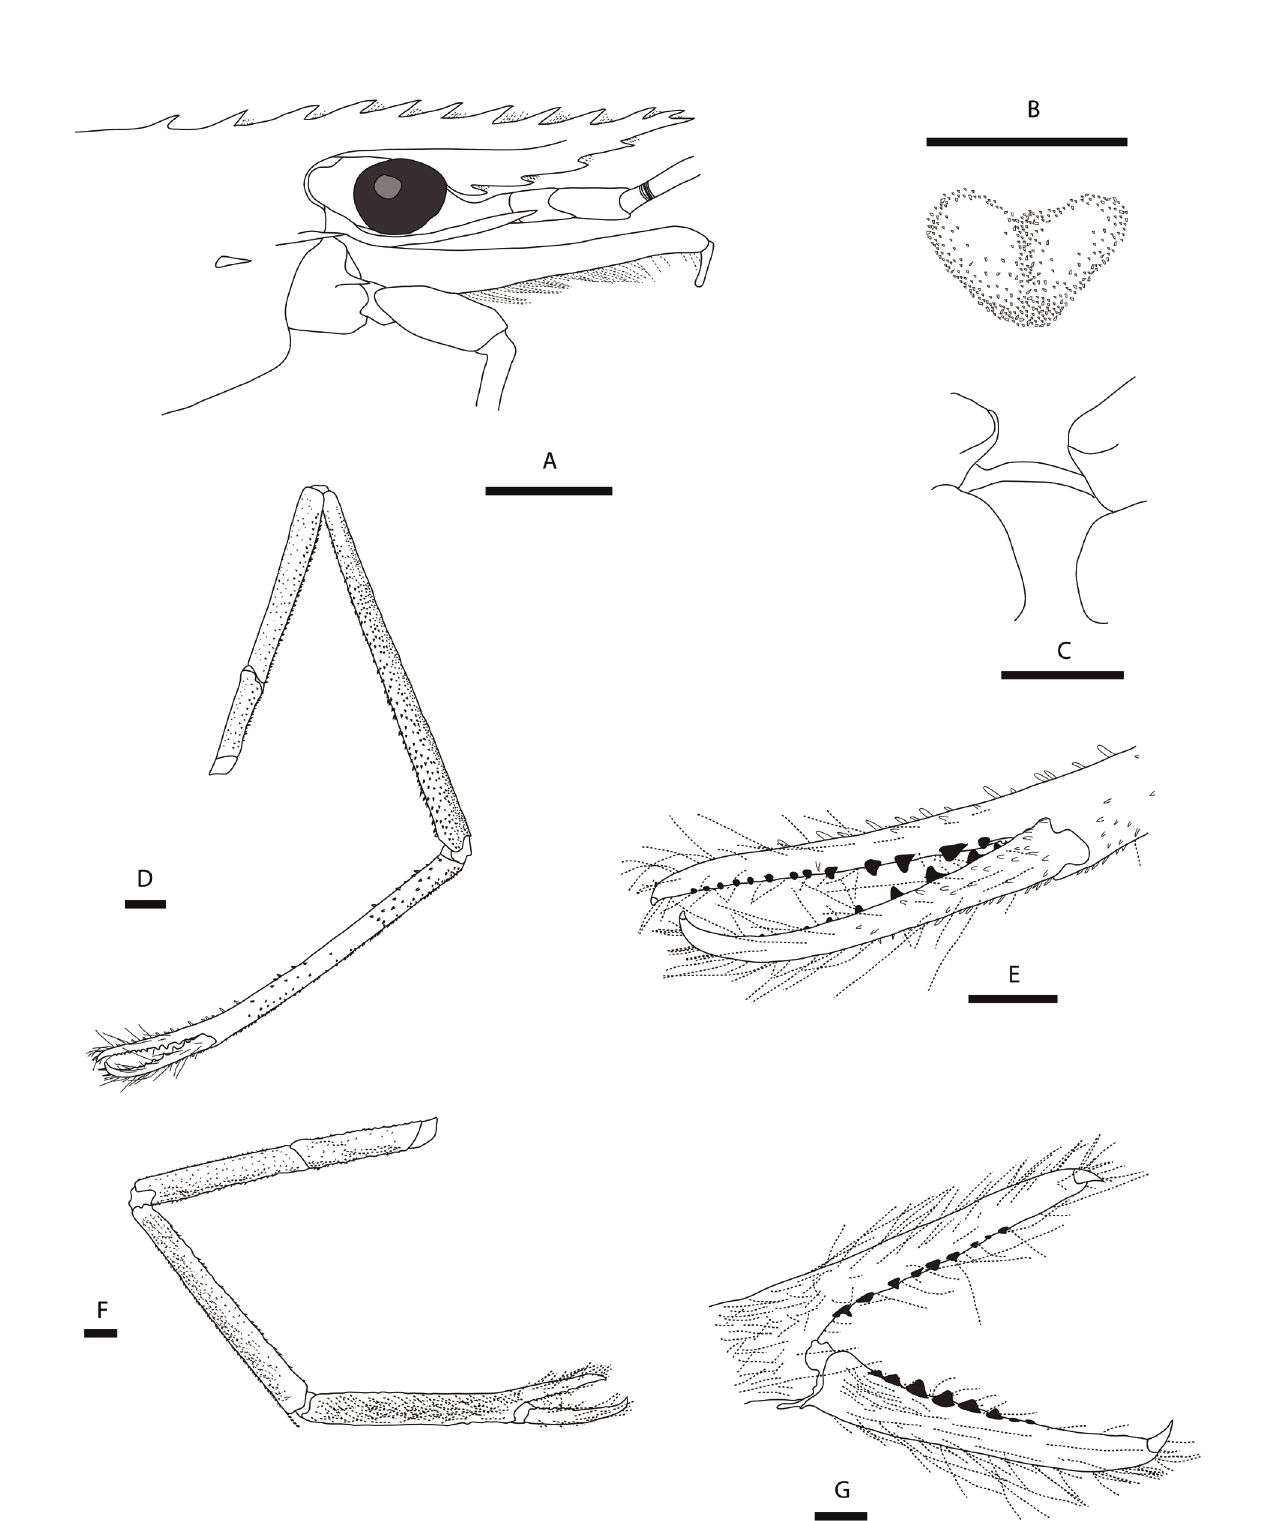
Fig. 3. Macrobrachium australe (Guérin-Méneville, 1838 in Guérin-Méneville 1829–1838), MNHN- IU-2013-13198. A . Cephalothorax. B . Epistome. C . Fourth thoracic sternite. D . Major second pereiopod. E . Major second pereiopod finger. F . Minor second pereiopod. G . Minor second pereiopod finger. Scale bars: A, E, G = 2 mm; B–C = 1 mm; D, F = 4